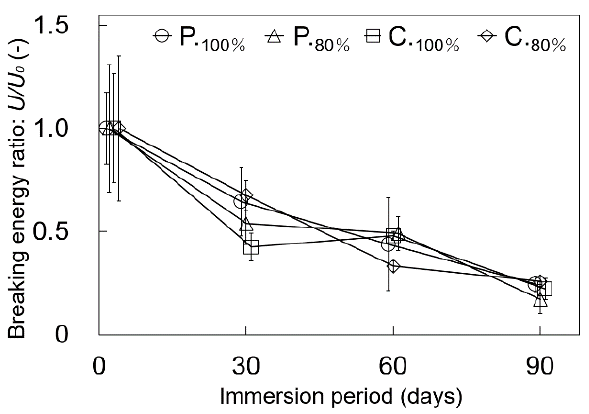
Figure 16. Comparison of the changes of the flexural breaking energies of the four test piece types brought about by the immersion. Average ± S.D., N = 5.